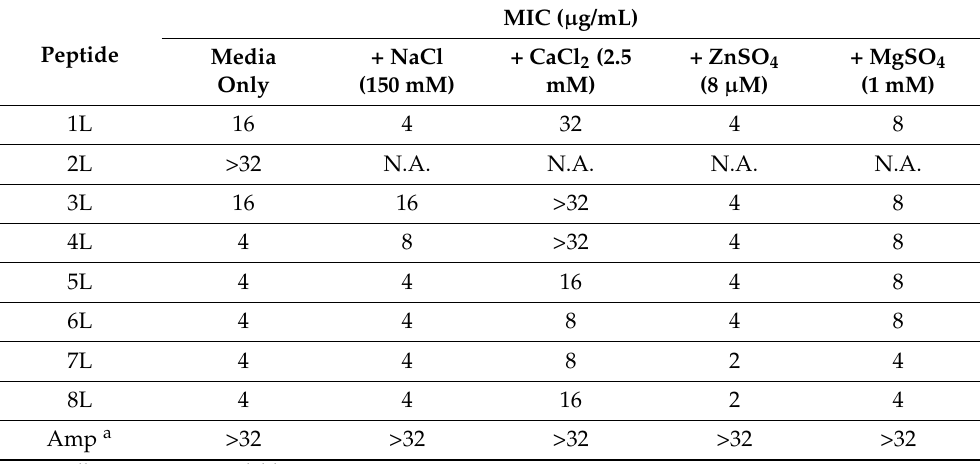
Table 2. MIC ( µ g/mL) of designed peptides against E. faecium strain C68 in the presence of physio- logical salt concentration.